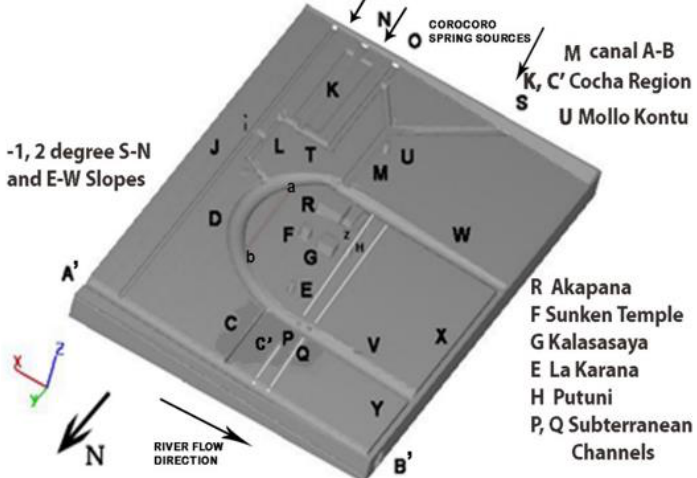
Figure 47. FLOW-3D CFD model of features in the moat location area, from [2], p. 173.